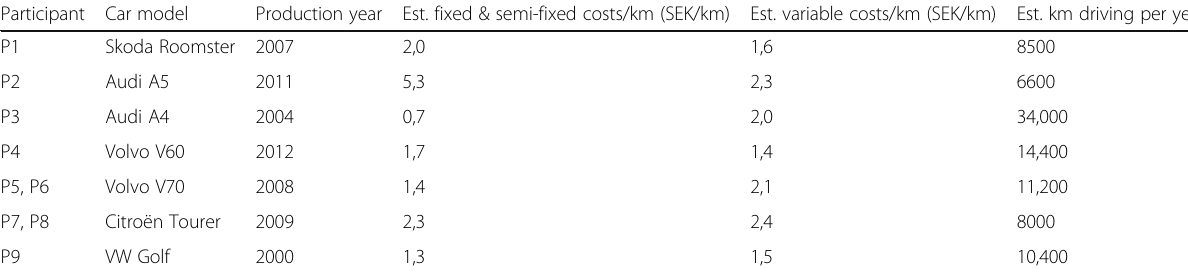
Table 2 Cost of ownership of cars Participant Car